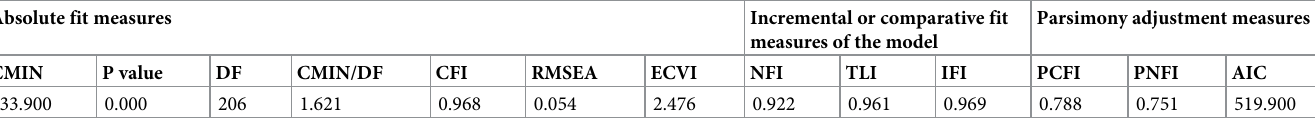
Table 9. Statistics of the goodness of fit model: Values obtained. Absolute fit